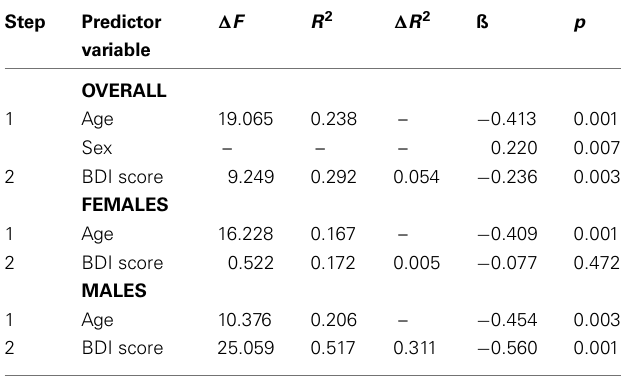
Table 4 | Predictive value of BDI score on